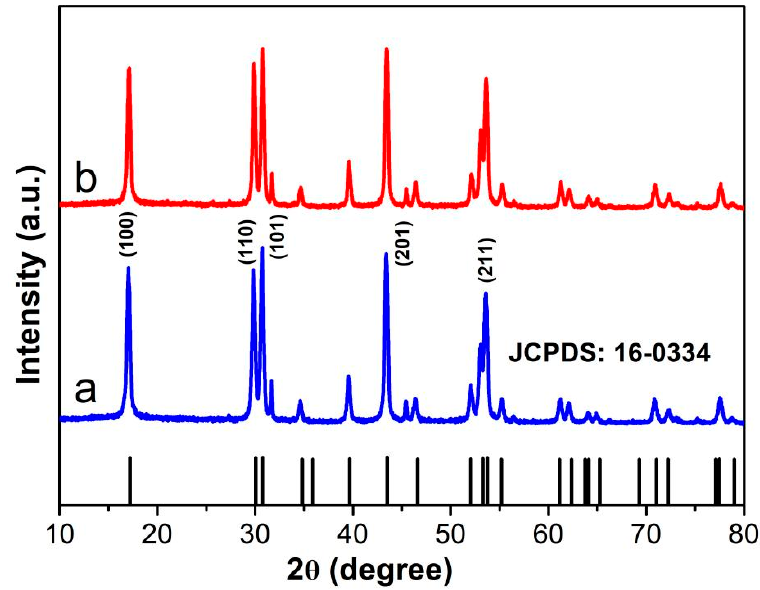
Figure 1. XRD mappings of ( a ) NaYF 4 :Yb 3+ /Er 3+ and ( b ) NaYF 4 :Yb 3+ /Er 3+ @NaYF 4 :Yb 3+ nanocrystals.